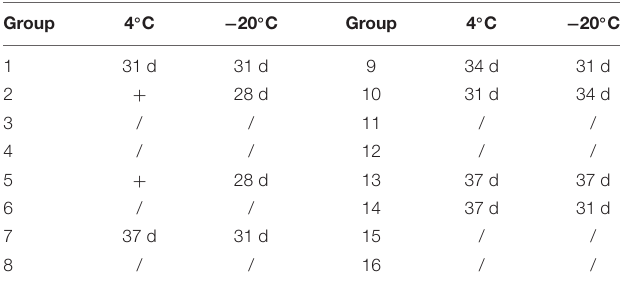
TABLE 5 | The time of culturable number of Salmonella decreased to 0 stored at different protocols. Group